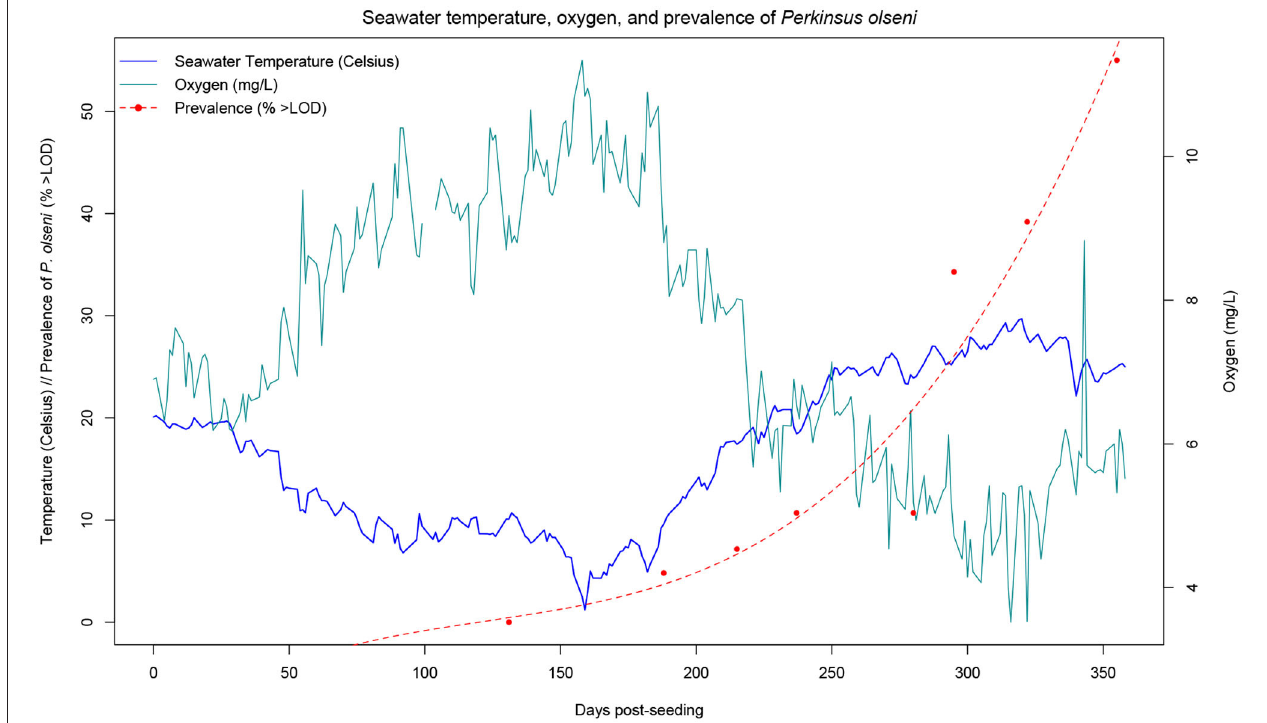
FIGURE 3 | Monthly average seawater temperature in Chioggia, Venice lagoon, and prevalence of P. olseni in clams. Prevalence is considered at the percentage of samples for which the parasite DNA was detected (but not necessarily quantifiable). Temperature and dissolved oxygen measurements were recorded daily by the Hydrobiological Station of Chioggia at the entrance of the lagoon (records available at: